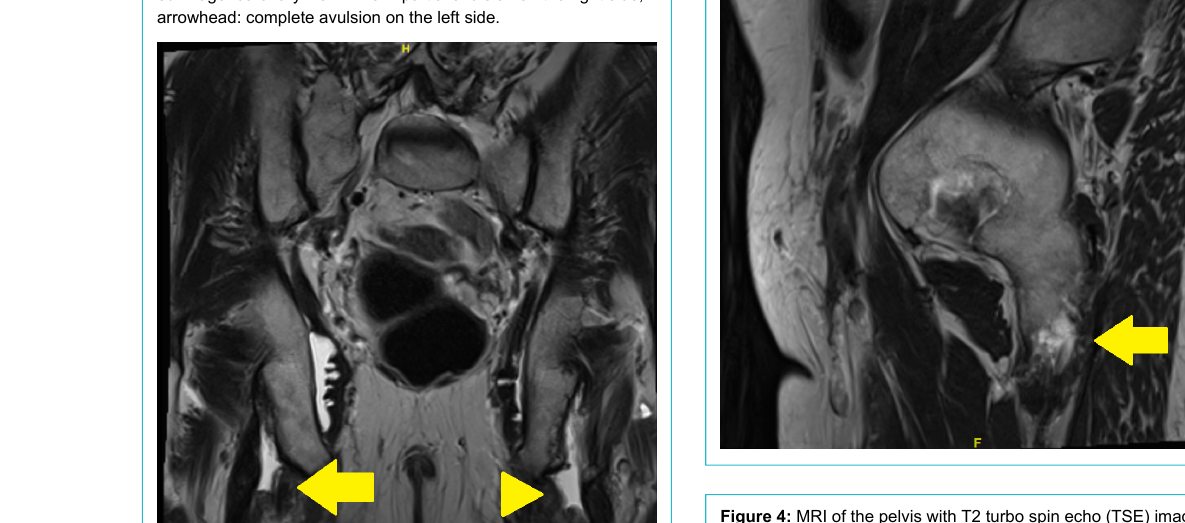
Figure 1: MRI of the pelvis with T2 turbo spin echo (TSE) weight- ed image: coronary view. Arrow: partial avulsion on the right side; arrowhead: complete avulsion on the left side.